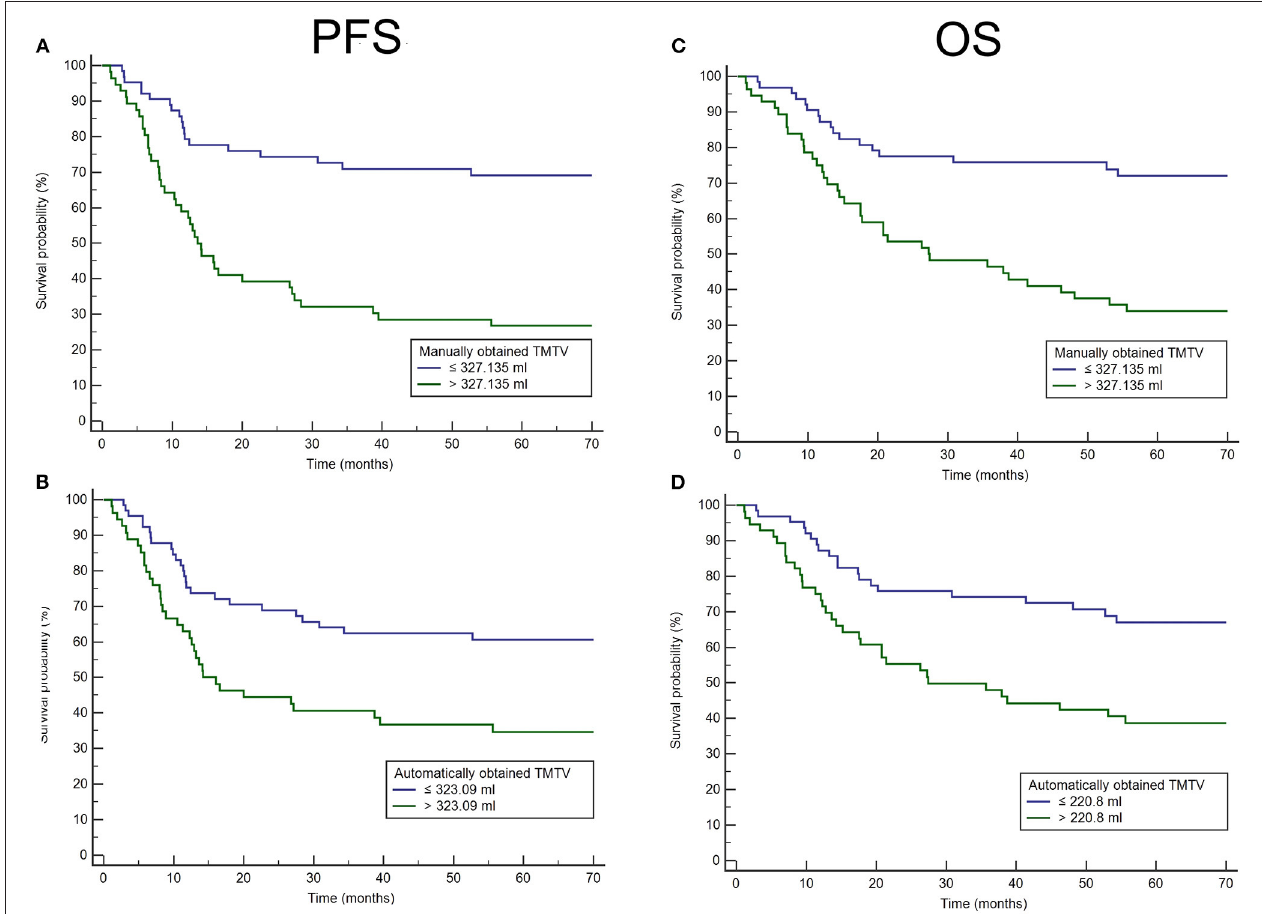
FIGURE 3 | Kaplan–Meier analysis of the population of diffuse large B-cell lymphomas (clinical research database) for progression-free survival (PFS) for manually obtained total metabolic tumor volumes (TMTVs) (A) and automatically obtained TMTVs (B) and for overall survival (OS) for manually obtained TMTVs (C) and automatically obtained TMTVs (D)